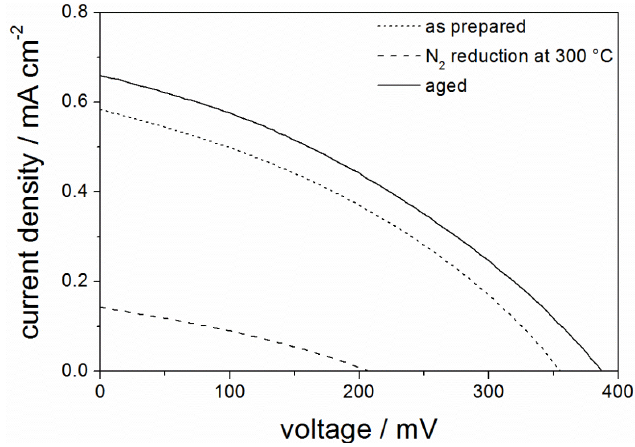
Figure 3. J - V -curves of dye-sensitized solar cells (DSSC) with D149-sensitized ZnO deposited into as prepared (···), N reduced (- -) and aged (―) mesoporous ITO films 2 prepared with PIB-PEO 3000.